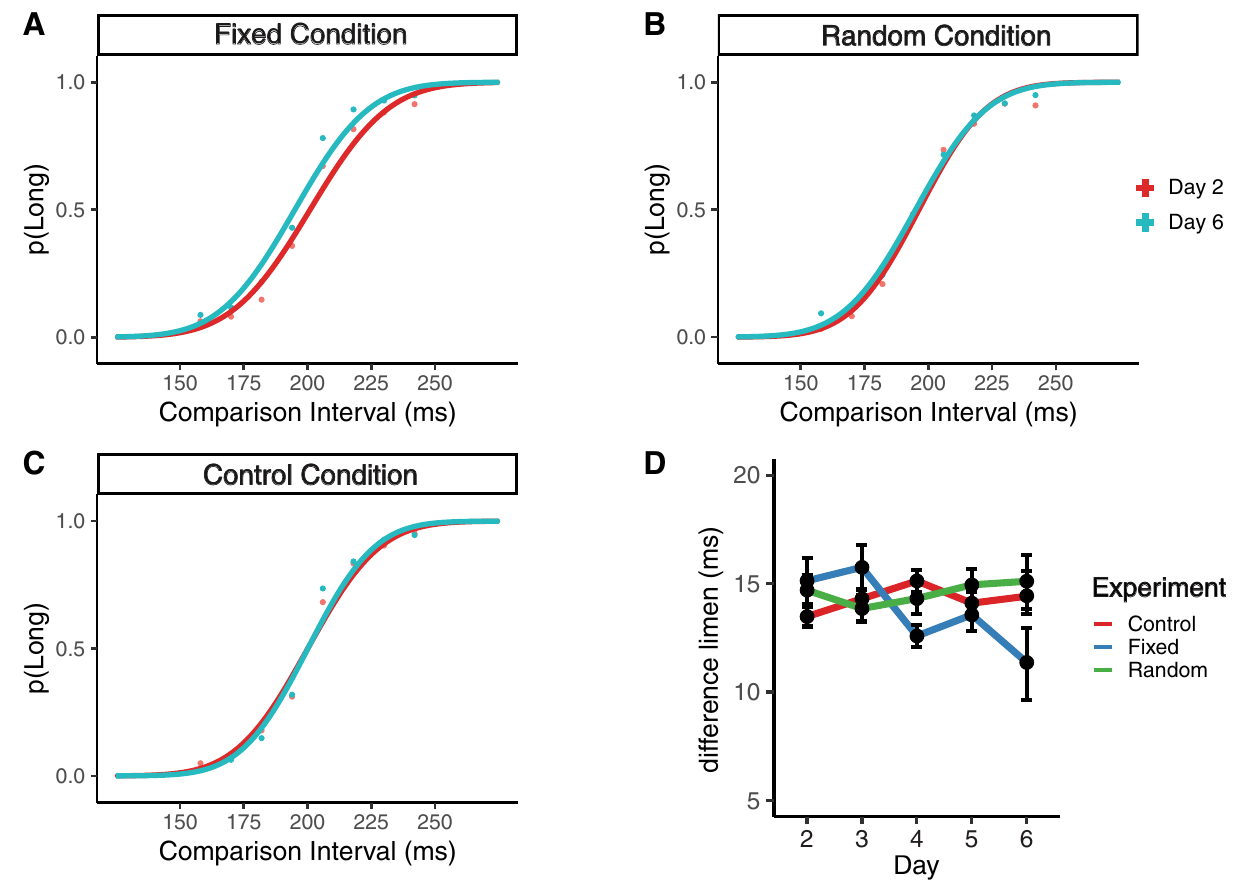
Figure 1. ( a – c ) Changes in the psychometric function in each group before and after training. ( d ) Changes in the difference limen (ms) across days. Error bars represent ±